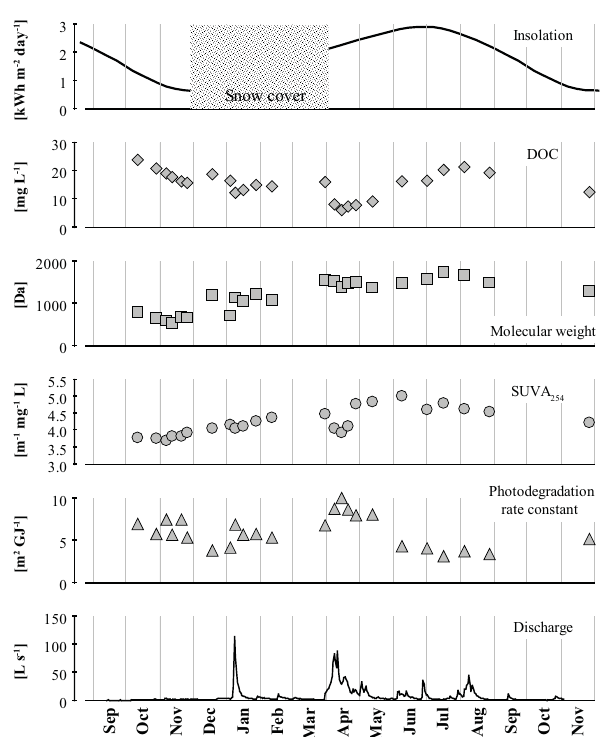
Fig. 2. Dickie 5 (DE5) tributary to Dickie Lake. Average incident in- solation, DOC, apparent molecular weight, SUVA 254 , photodegra- dation rate constant and mean daily discharge during hydrological year